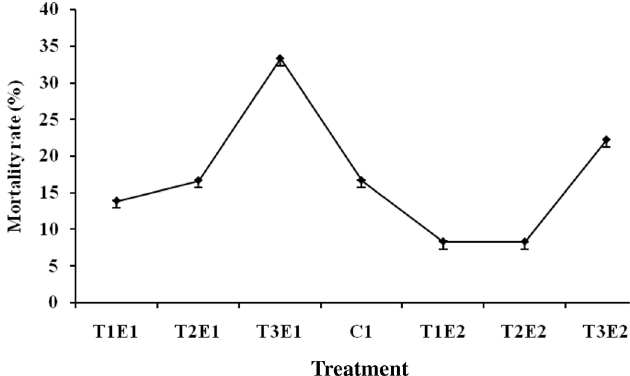
Fig. 1. Mortality rate (%) of C. carpio in different